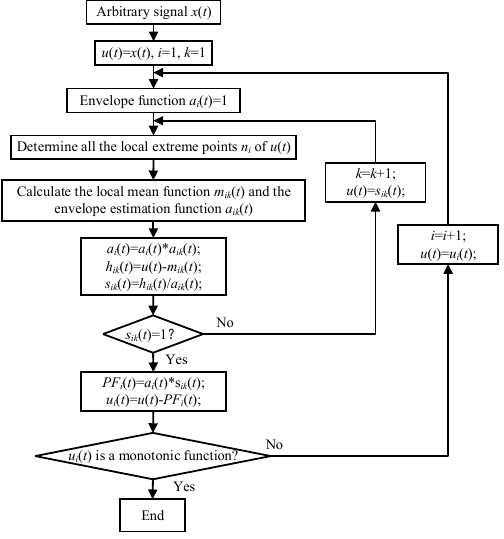
Figure 1. The flowchart of LMD algorithm.